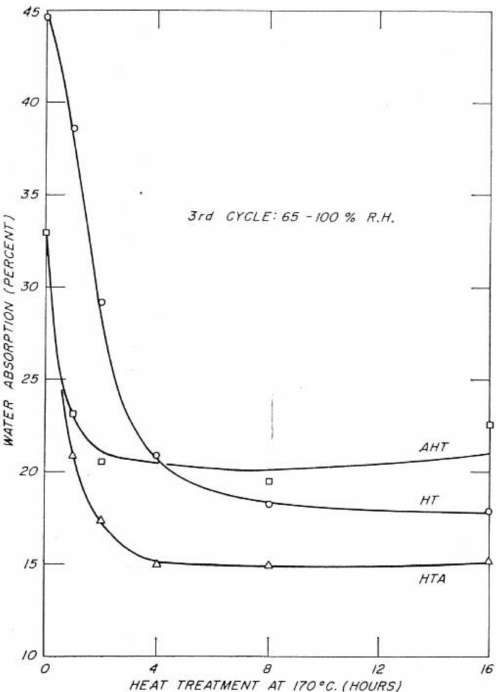
Figure 10. Moisture absorption of hardboards on the third cycle of which went from 65% relative humidity (RH) to 100% RH versus heat treatment time. (HT) heat-treated only, (AHT) acetylated and then heated, (HTA) heat-treated and then acetylated [16].